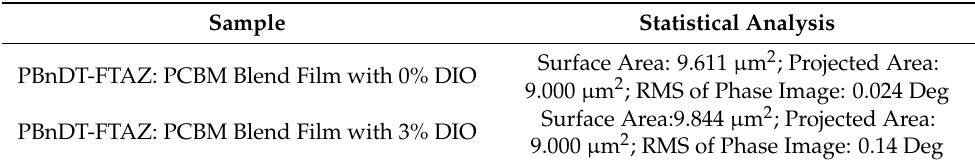
Table 1. Summary of Statistical Quantities of AFM Images.